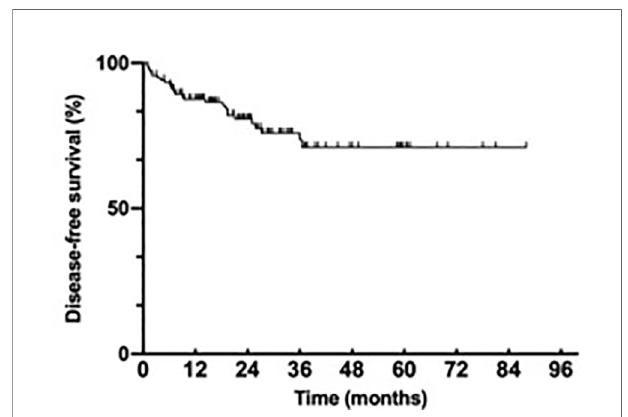
FIGURE 1 | Disease free survival